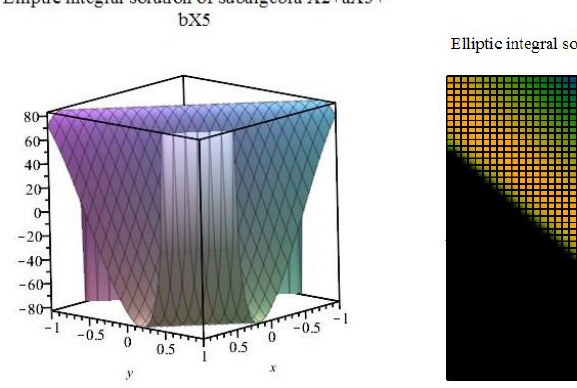
Figure 20. Solitary wave depiction of elliptic integral solution (68) at t = 1.